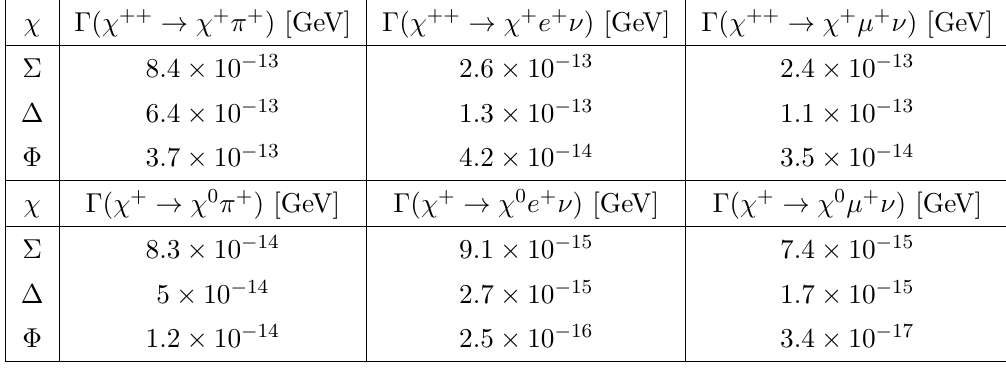
Table 4 . Partial decay widths [in GeV] of the heavier charged exotics to the lighter ones and pion/lepton final